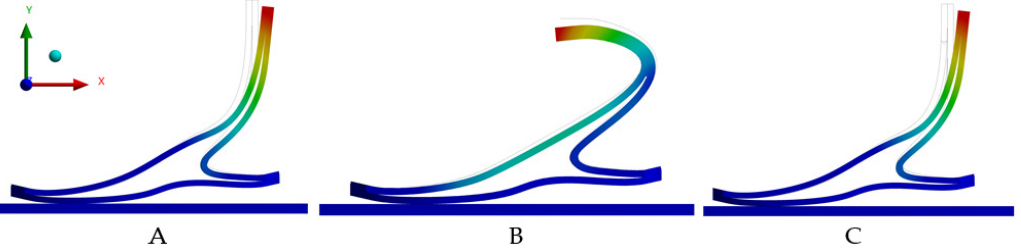
Figure 16. Comparative static analysis of ESAR prosthesis.